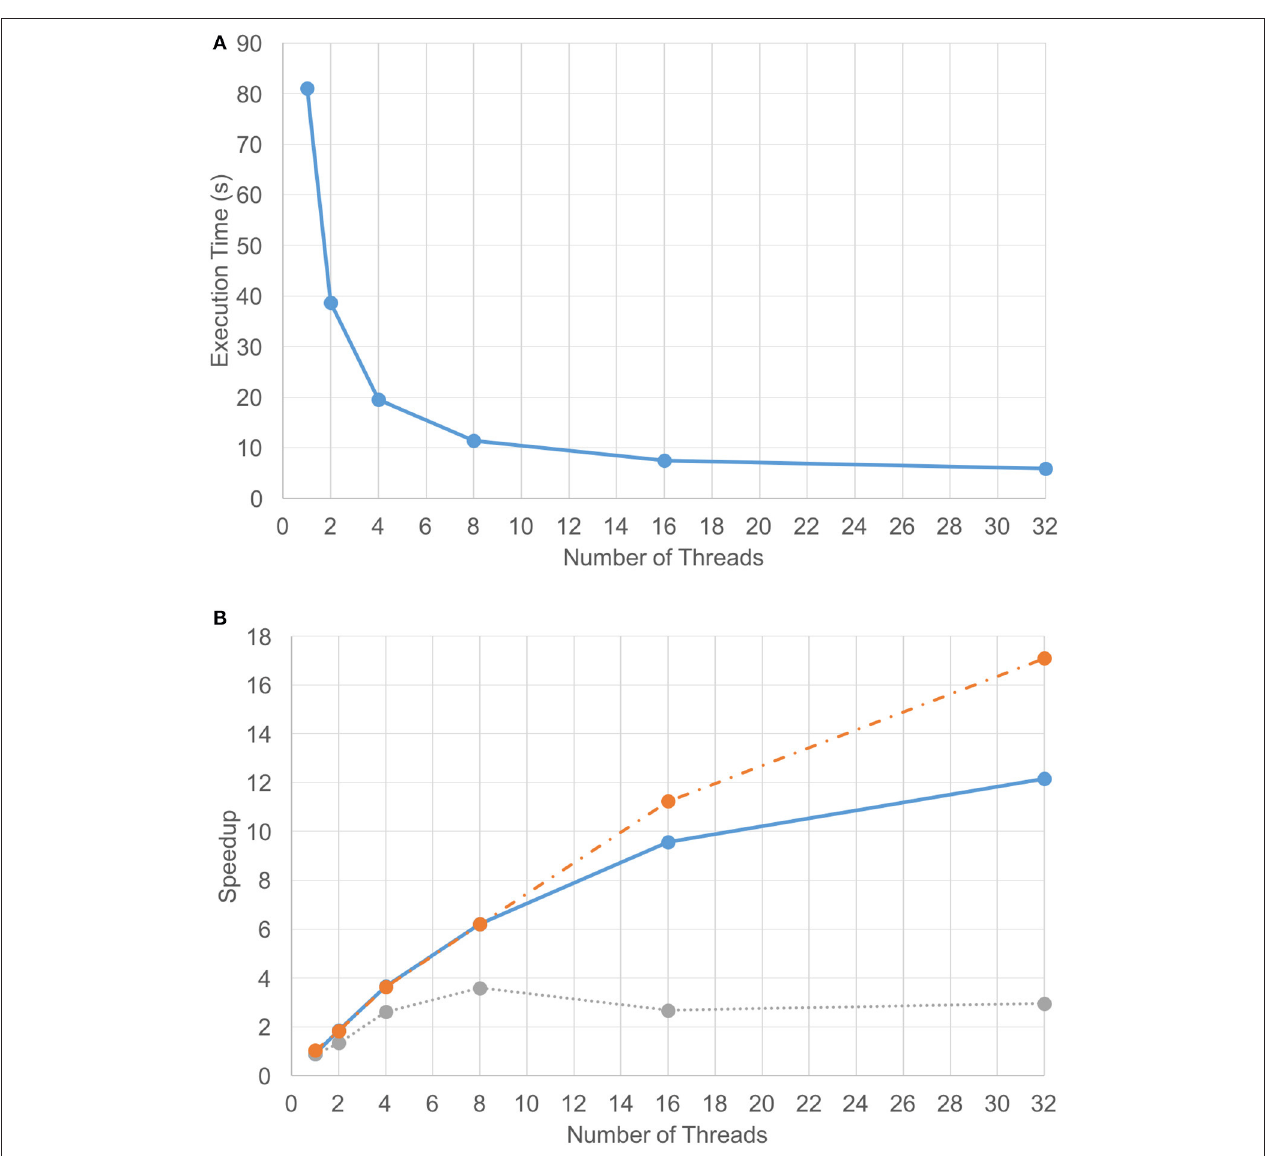
FIGURE 5 | Computation-only performance scalability. Graphs showing (A) execution time and (B) speedup of the 3D VF-ABM for different number of threads. Notice that the average speedup of model function routines (orange-dotted) is much higher than the average speedup of the update routines (gray-dotted). The model function routines performed more computations than memory access operations, while the update routines performed more memory access operations than computations. As a result, a good scalability in model function routines was obtained but the scalability of update routines were relatively poor. Despite the memory-bound update functions, the overall speedup of the program (blue-solid) is still satisfactory.